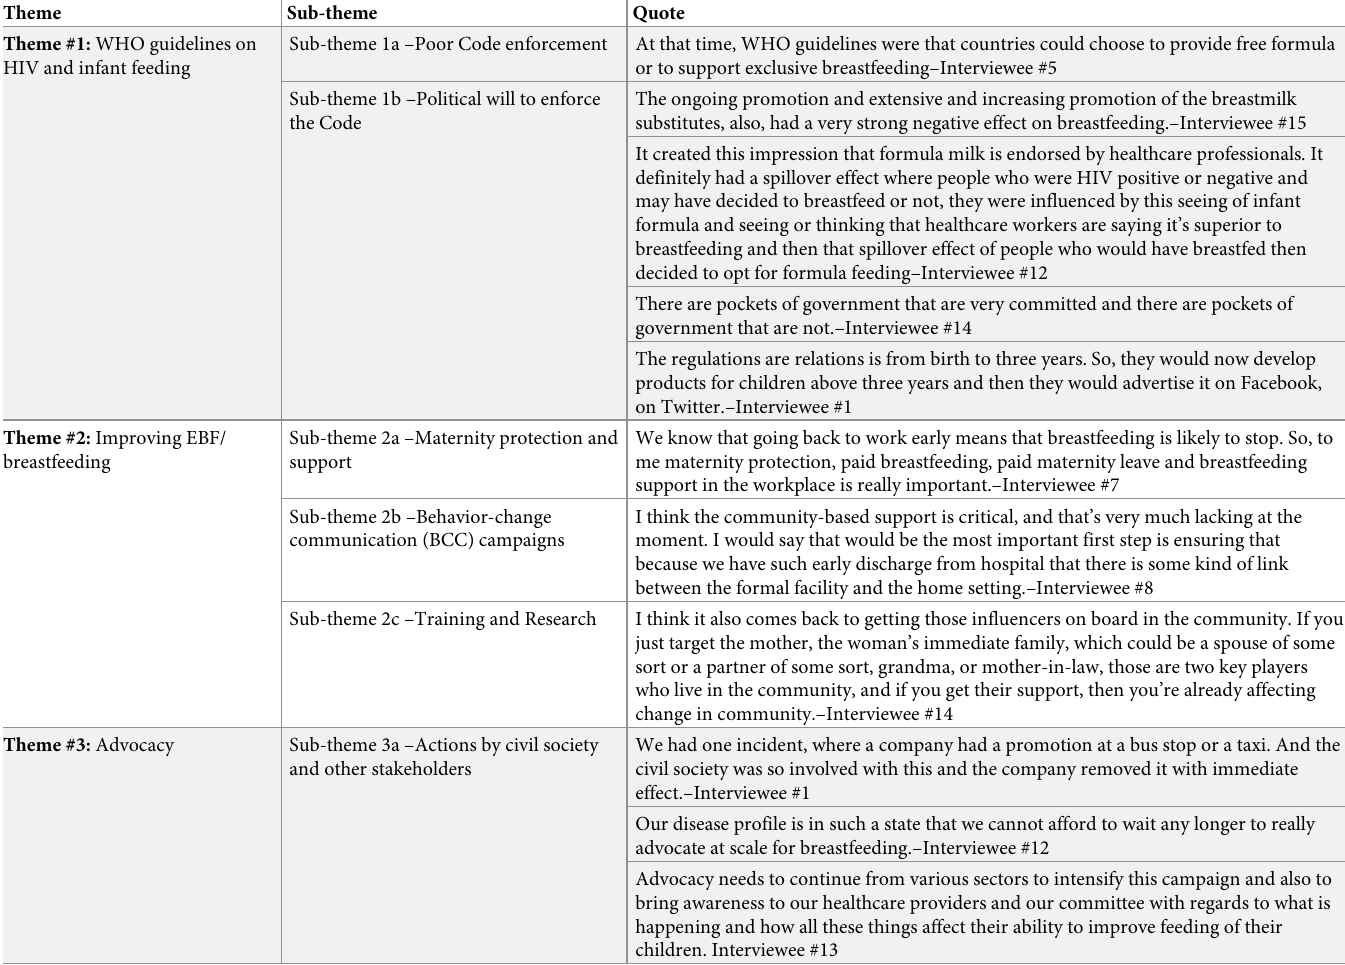
Table 2. Themes and